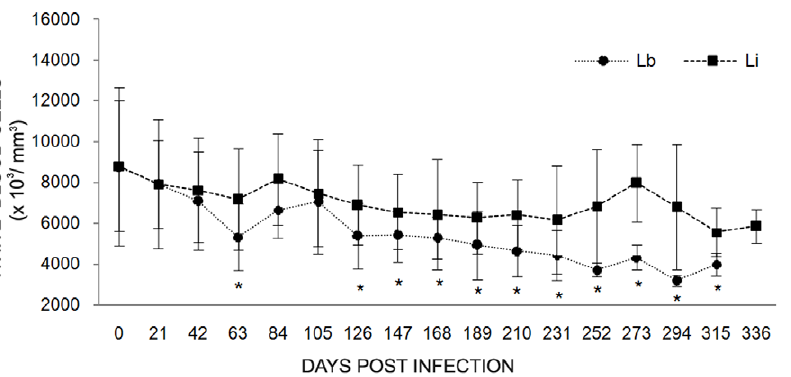
Figure 2. Kinetics of white blood cell counts in Thrichomyslaurentius experimentally infected by Leishmaniabraziliensis (Lb) or Leishmaniainfantum (Li). Each point represents the mean values and standard errors. The * indicates the significant difference between values obtained from non-infected rodents (day 0) and and rodents infected by L. braziliensis .